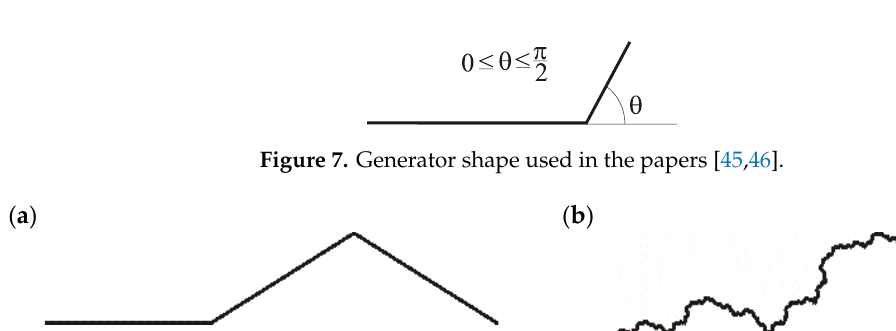
Figure 6. Generator shape proposed by Peng and others in the paper [44] ( a ) and an example of fractal obtained on its basis ( b ).